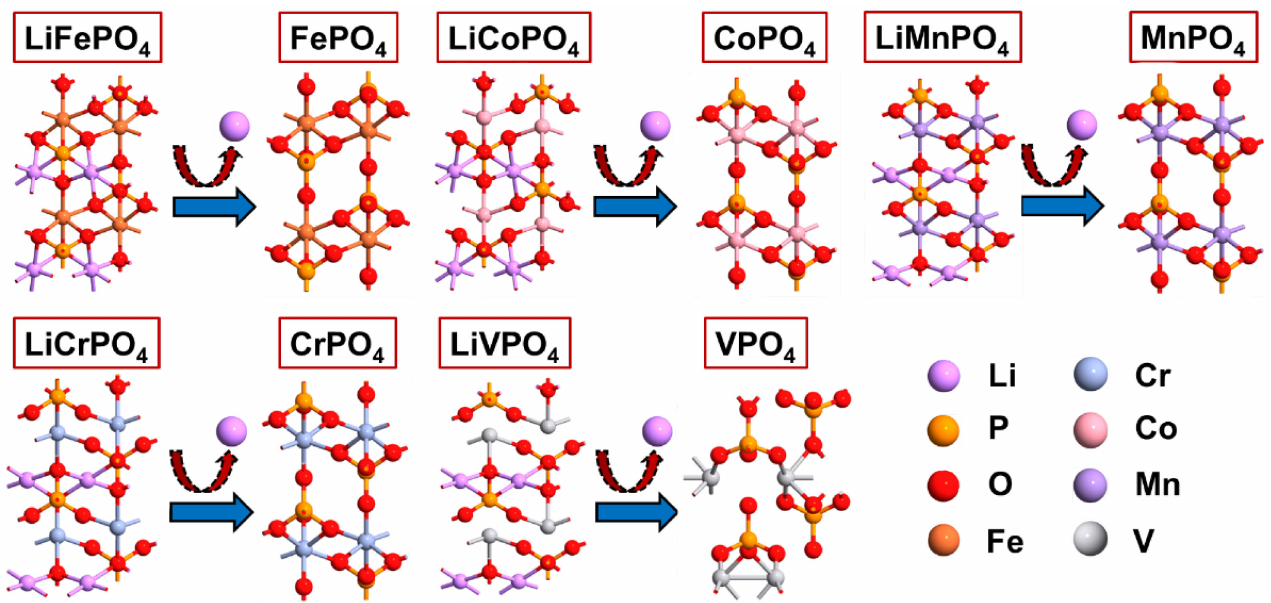
Figure 3. Schematic representation of optimized unit cells of different LiMPO 4 (M = Fe, Co, Cr, Mn, and V) and MPO 4 (M = Fe, Co, Cr, Mn, and